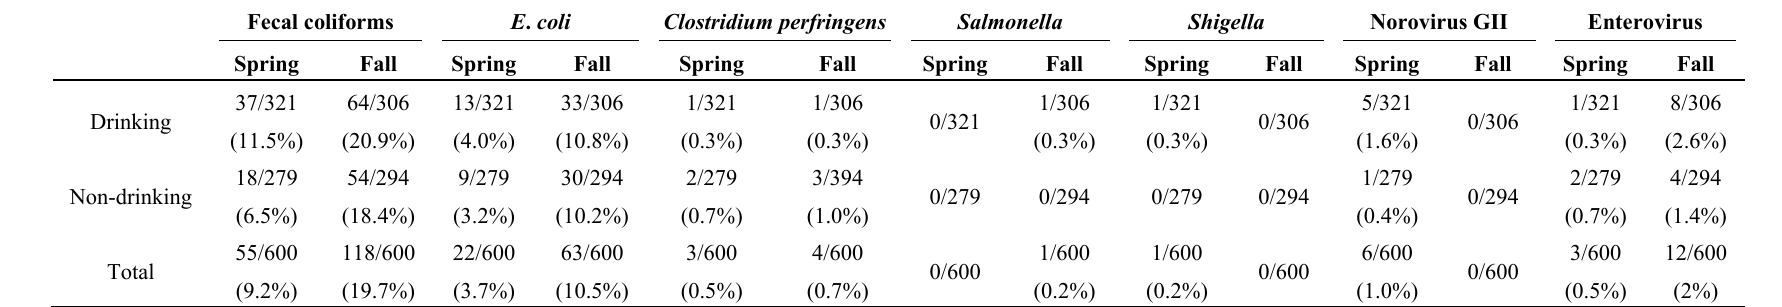
Table 4. Detection of